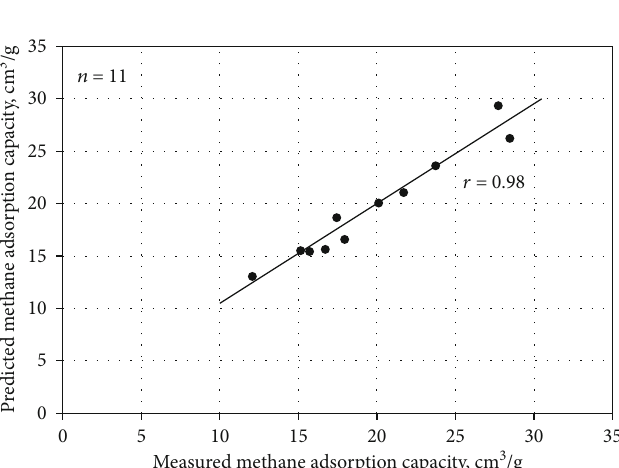
Figure 4: Scatter plot of measured versus predicted methane adsorption capacity of the No. 2